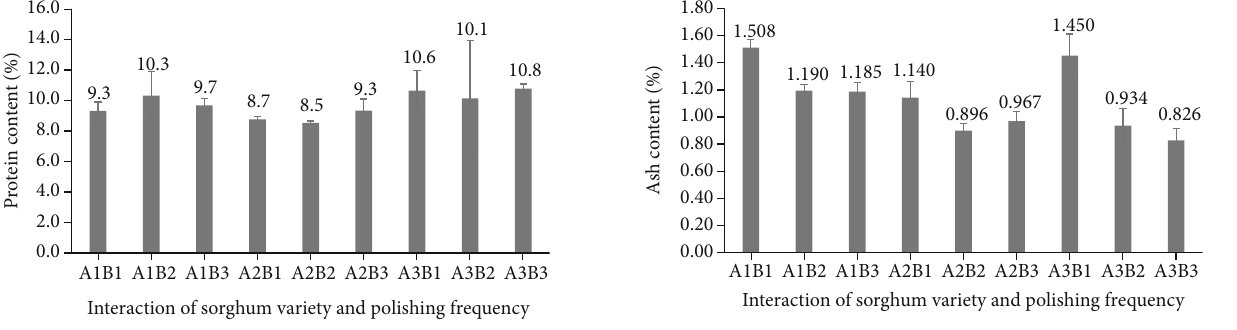
Figure 12: Protein content of three varieties of polished sorghum grains at di ff erent polishing frequencies.